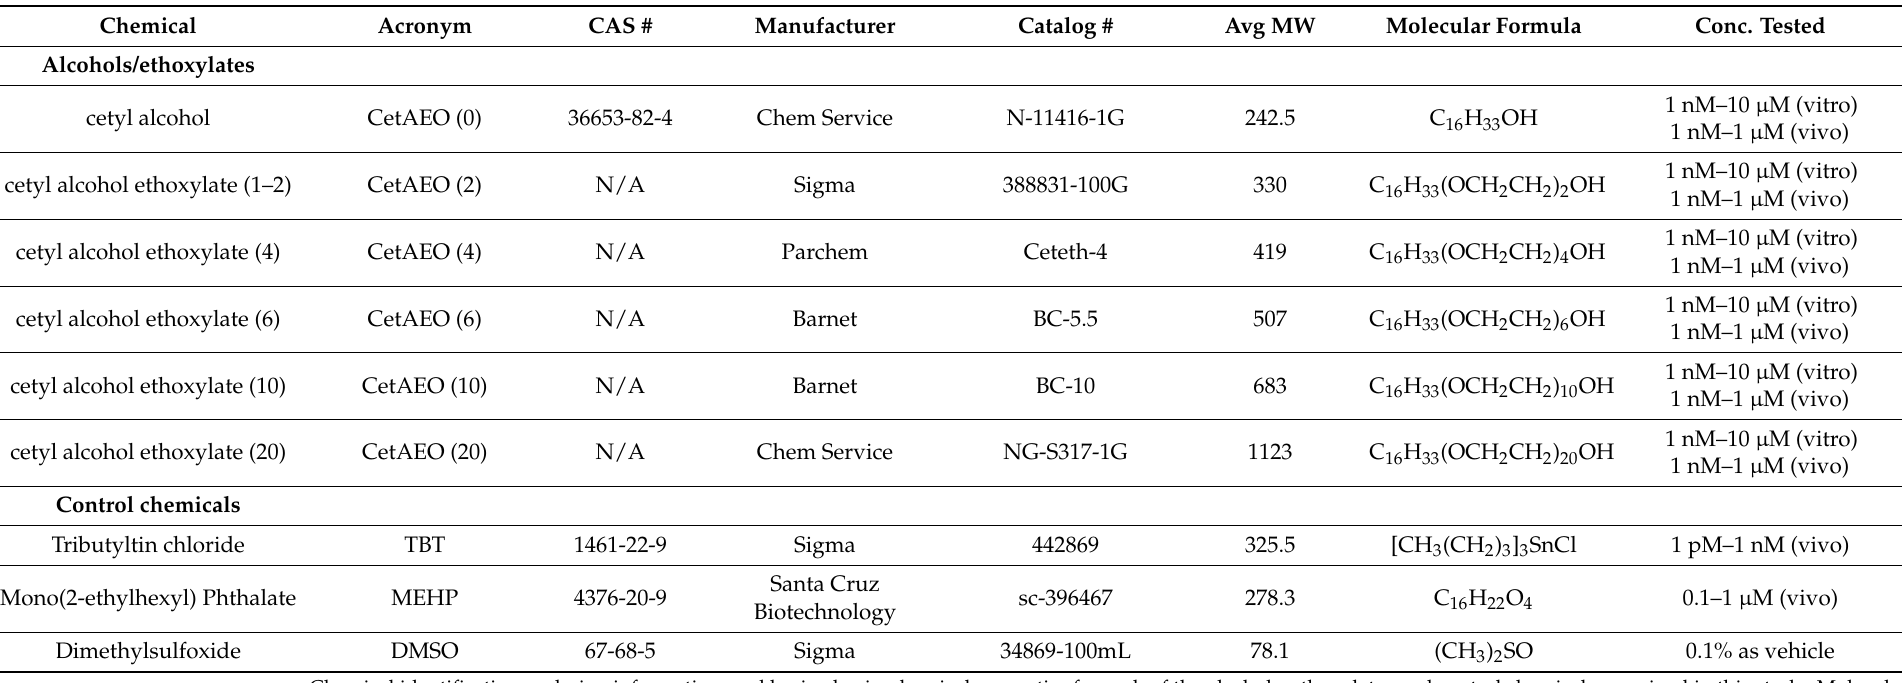
Table 1. Alcohol Ethoxylates and Control